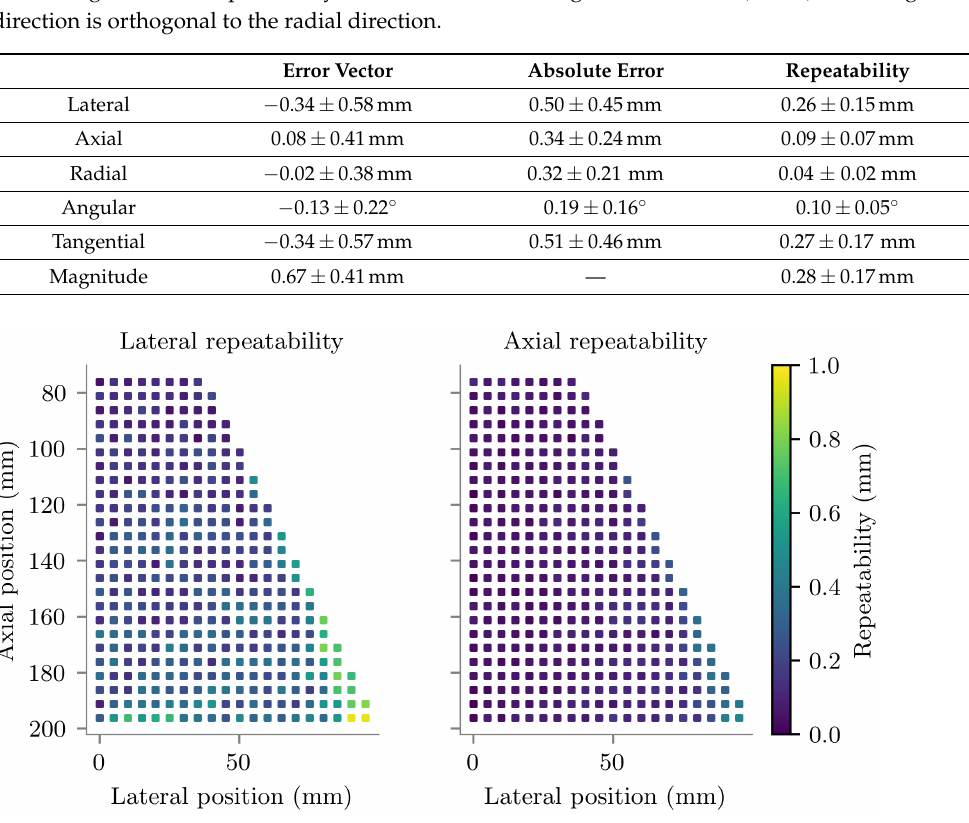
Figure 8. Standard deviation of the tracked lateral ( left ) and axial ( right ) locations measured in vitro, plotted at their corresponding true Cartesian positions relative to the centre of curvature of the